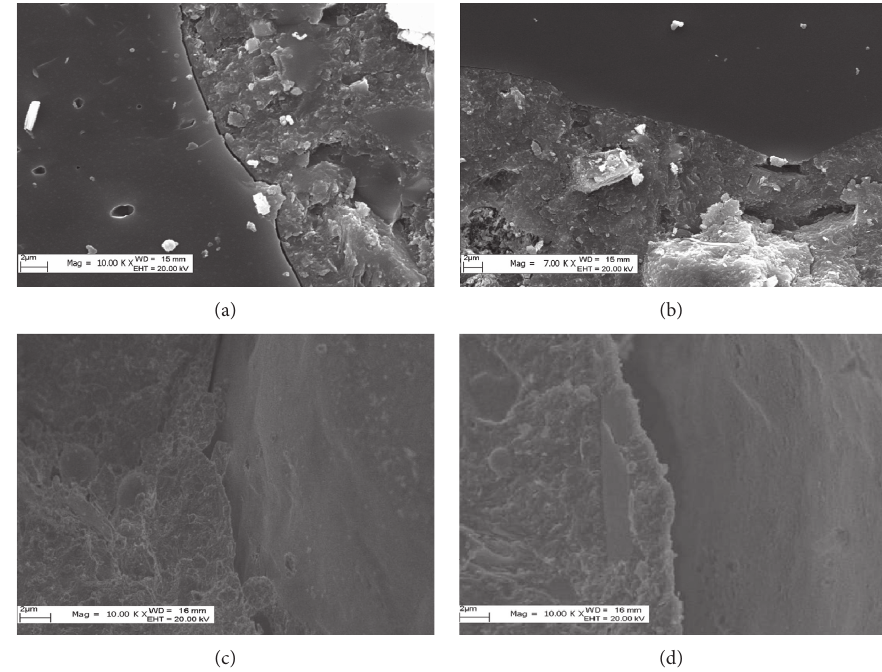
Figure 6: The cement paste-aggregate interface transition zone (ITZ) of steel fiber UHPC and rubber UHPC: (a) steel fiber UHPC with 0.5% steel fiber; (b) steel fiber UHPC with 1.5% steel fiber; (c) rubber UHPC with 40 mesh (the length is 0.2–0.4mm) rubber; (d) rubber UHPC with 8 mesh (the length is 2–4 mm)